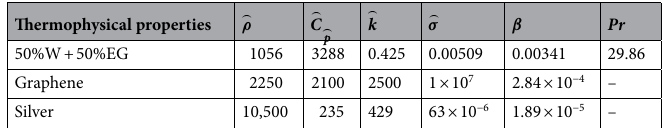
Table 1. Thermophysical characteristic of the water, ethylene glycol and graphene nanoparticles 41–45 .